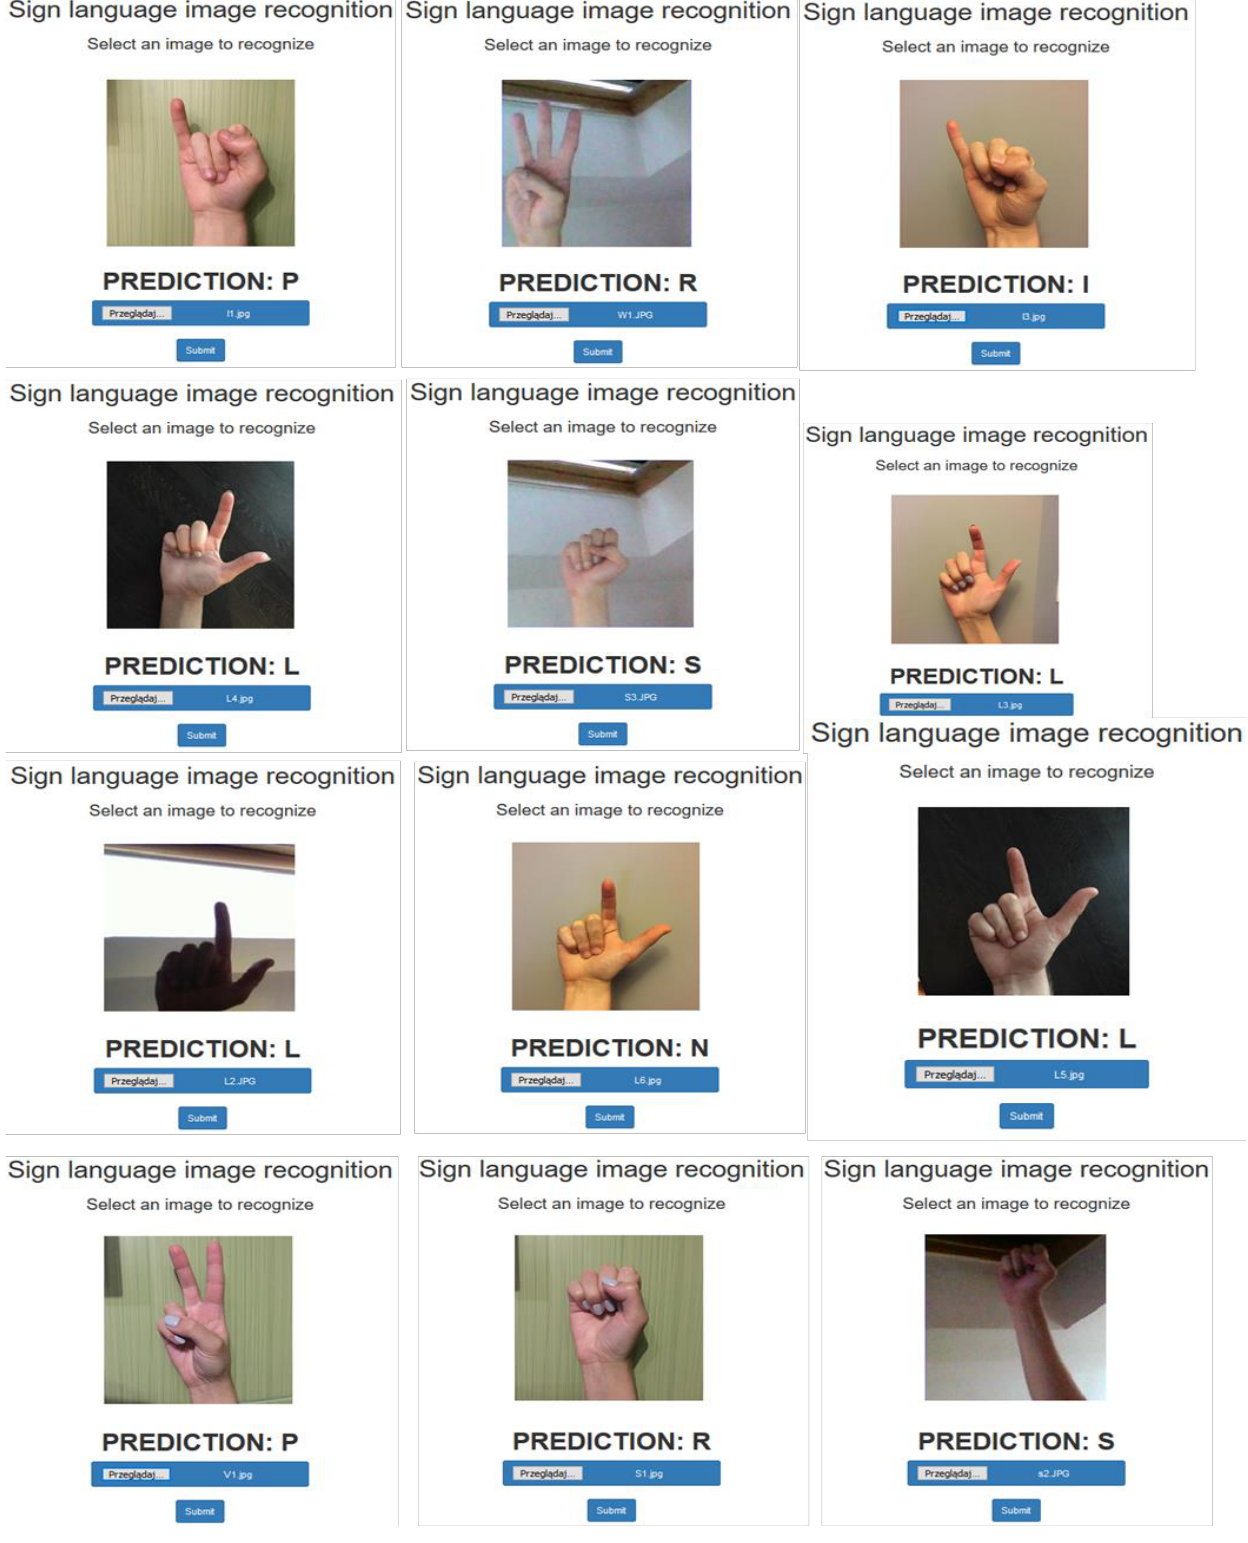
Figure 6. A sample of recognition results of images unknown to the network. The presented photos show that 24 out of 40 analysed signs were correctly recognized. Figure 7 shows incorrectly recognized photos and their comparison with the real sign.